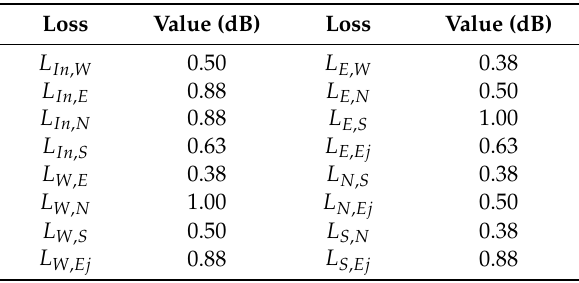
Table 2. Loss value in 5 × 5 Crux router.